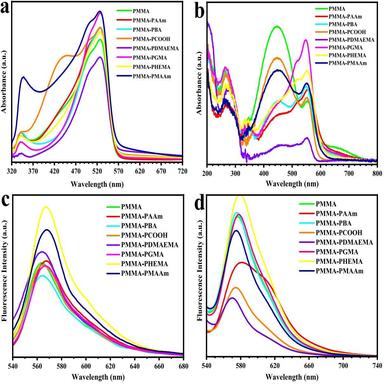
Investigation of optical properties for multi-color photoluminescent polymer nanoparticles by UV–Vis spectroscopy in (a) colloidal solution state and (b) solid state, and by fluorescence spectroscopy in (c) colloidal solution state (with excitation of 520 nm), and (d) in solid state with excitation of 520 nm.